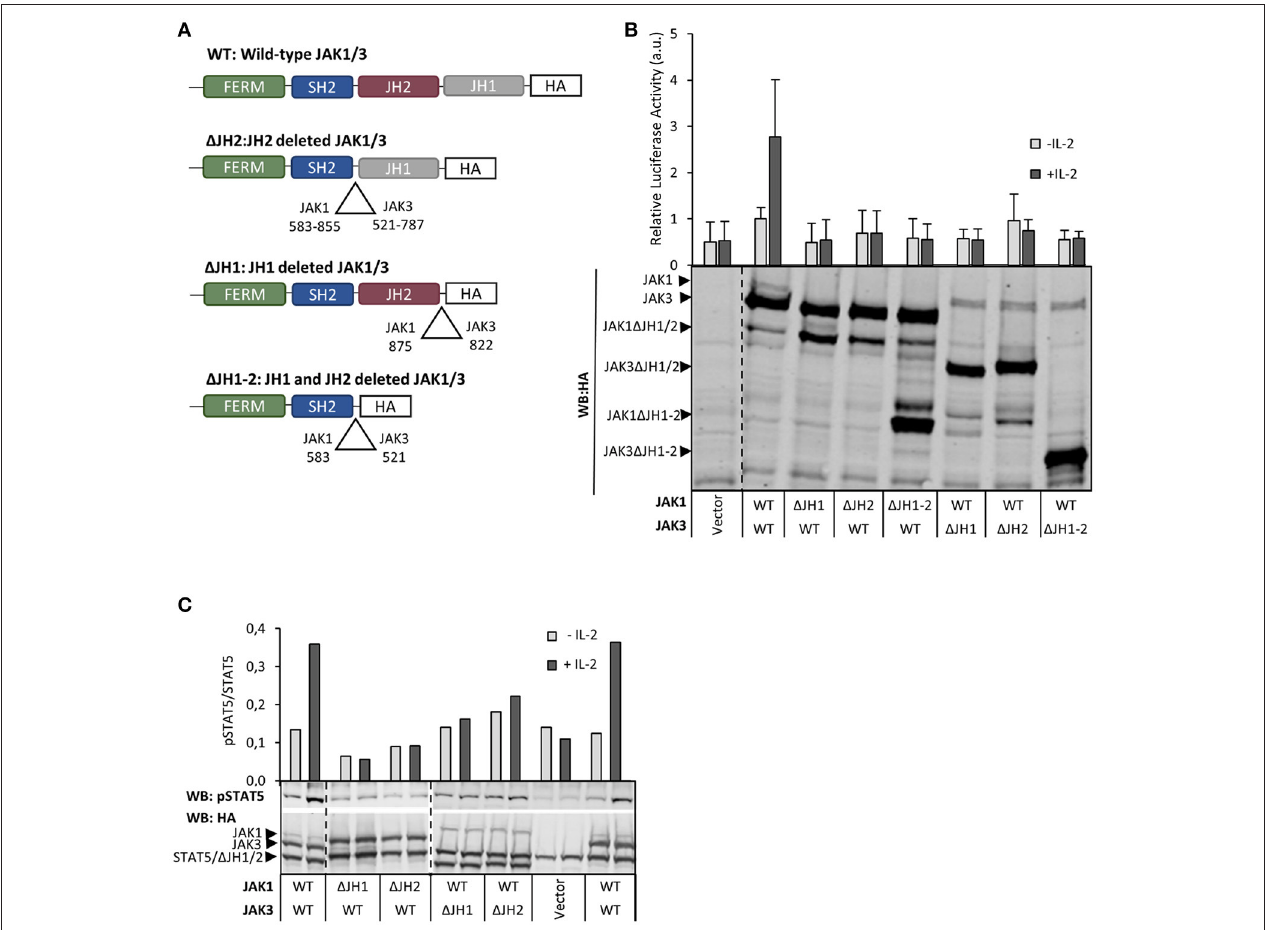
FIGURE 1 | Both JH1 and JH2 in JAK1 and JAK3 are required for functional IL-2 signaling. (A) Schematic presentation of JAK1 and JAK3 wild-type (WT) and domain deletion constructs. (B) Both JH1 and JH2 of JAK1 and JAK3 are required for IL-2 dependent STAT5 activation. U4C γβ cells were transfected with JAK1 WT, JAK3 WT and domain deletion constructs together with STAT5 responsive reporter SPI-luc2 ( 28), either with Renilla or pRL-TK control vector (see Materials and Methods) and starved/stimulated. Similar results were obtained with both control vectors. Data shows averages and SD from normalized values combined from three independent experiments, each having triplicate samples. The expression of JAK1/JAK3 constructs was analyzed by anti-HA Western blotting. (C) IL-2-induced pSTAT5 requires both JH1 and JH2 in JAK1 and JAK3. STAT5 phosphorylation and expression of JAK1, JAK3 and STAT5 were detected from cell lysates from transfected U4C γβ cells by immunoblotting with HA- and pTyr694 STAT5 antibodies. Similar results were obtained in three independent